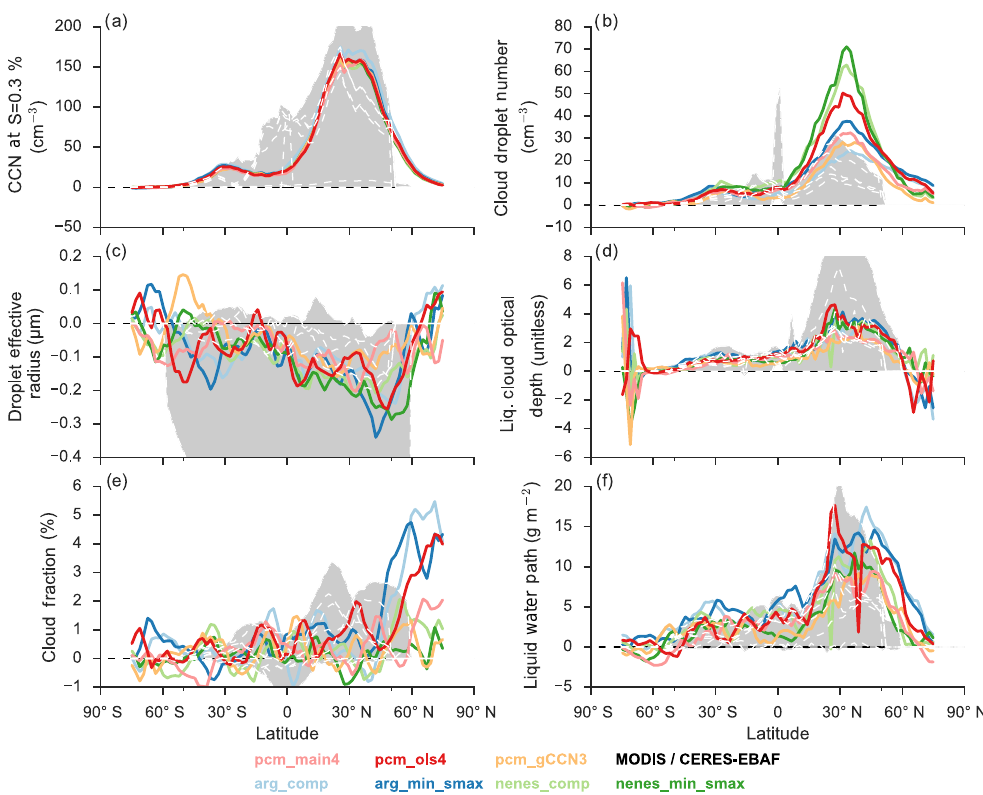
Figure 6. Same as Fig. 5, except illustrating differences in indicated fields between preindustrial (PI) and present-day (PD) emissions scenarios. CCN here is computed at an altitude of 1km in the model.